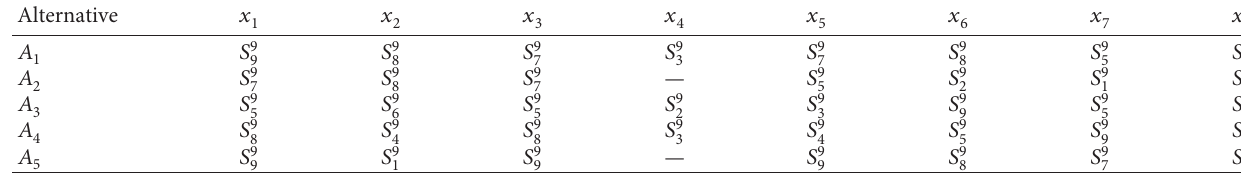
(forum reviews 9